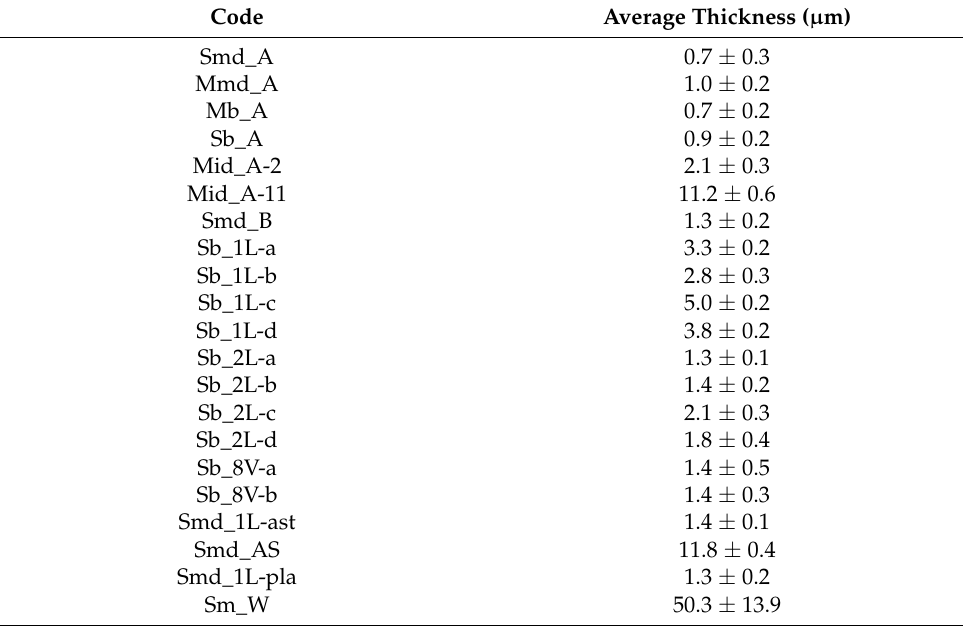
Table 3. Average thickness of the samples obtained by eddy-current probe. Standard deviation at 1 σ